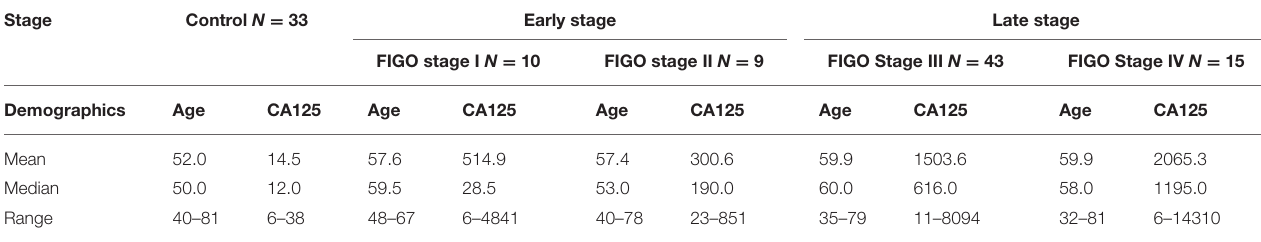
TABLE 1 | Demographics of samples used in this study. CA125 are shown as kU/L. Stage Control N = 33 Late stage FIGO stage I N = 10 FIGO stage II N = 9 FIGO Stage III N = 43 FIGO Stage IV N =